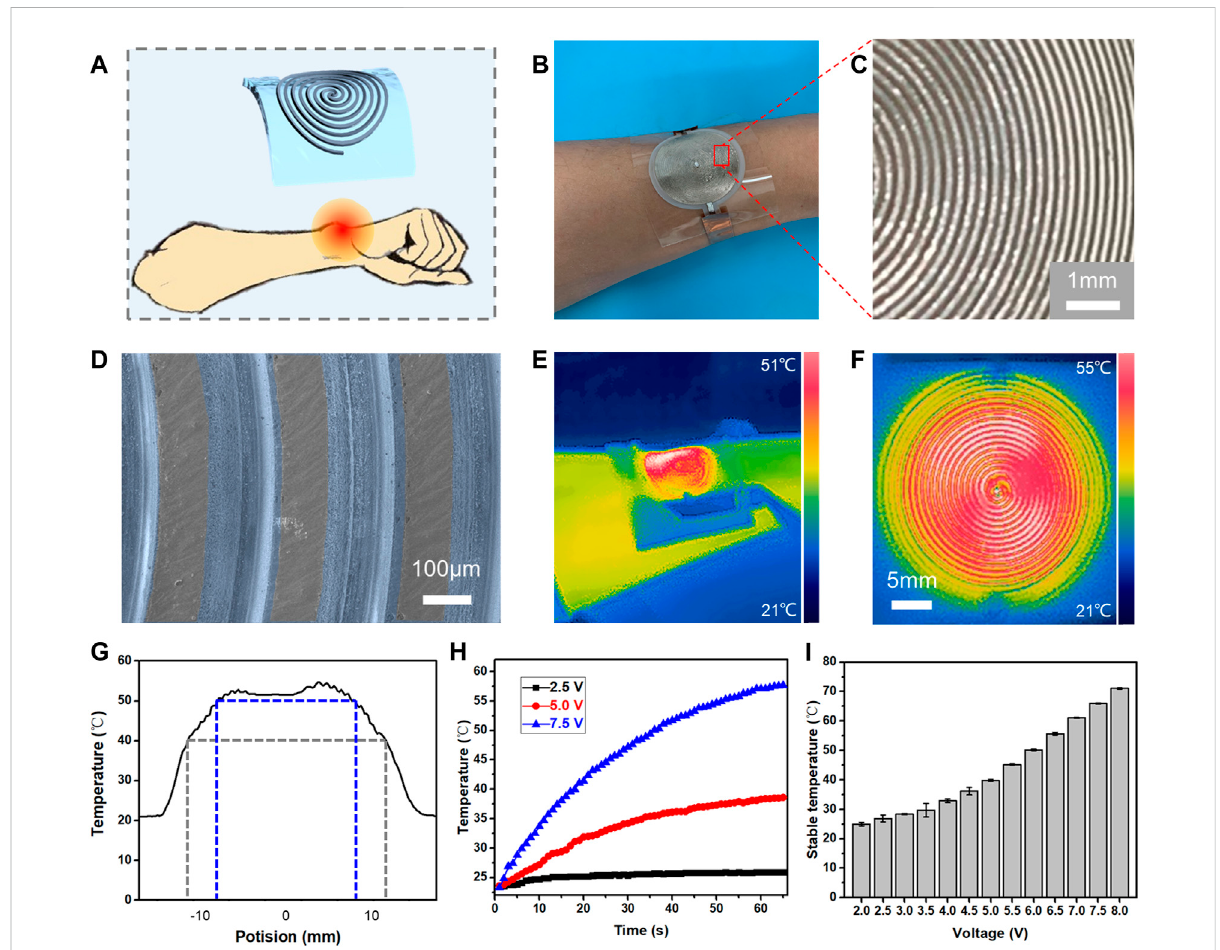
FIGURE 6 Uniformity oflaser-induced fl exible microheater via combiningO-EGaIn andthesacri fi cial layer. (A) Schematicoftheelectronic skin to control the local temperature of the body. (B) Photograph of as-prepared fl exible microheater. (C) Uniformity of the liquid metal line. (D) SEM image of the liquidmetalspiral line. (E,F) Infraredtemperature distribution imageofthe fl exiblemicroheater. (G) Temperature fi elduniformitytestofmicroheater. (H) Changeintemperatureofthemicroheaterasafunctionoftime. (I) Relationshipbetweentheinputvoltageandthestabletemperatureofthe